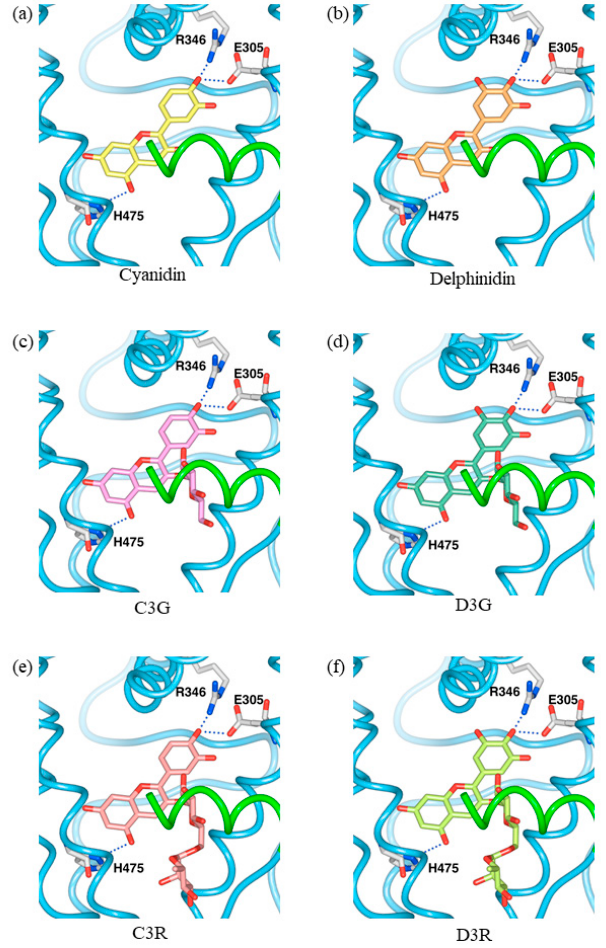
Figure 5. Ligand-binding pocket of the active ER β conformation (PDB ID: 3OLS) showing interactions with ( a ) cyanidin; ( b ) delphinidin; ( c ) cyanidin-3-glucoside (C3G); ( d ) delphinidin-3-glucoside (D3G); ( e ) cyanidin-3-rutinoside (C3R) and ( f ) delphinidin-3-rutinoside (D3R). Helix 12 is colored green.